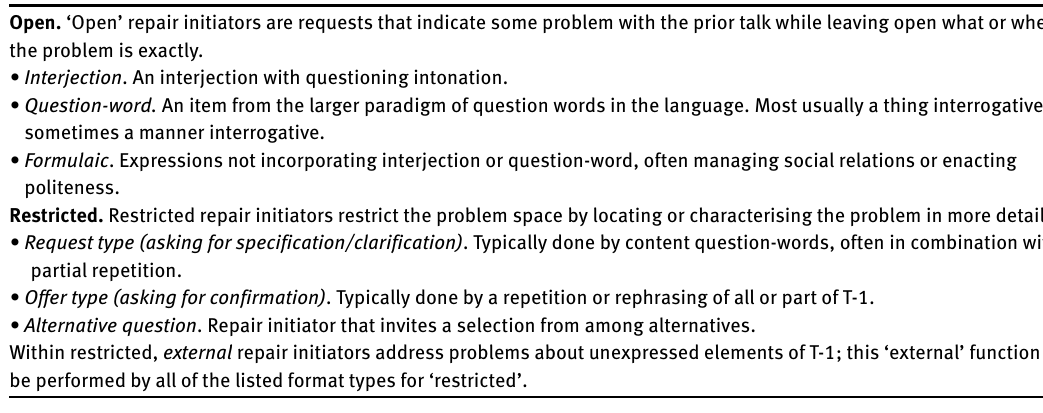
Table 2: Some basic format types for other-initiation of repair Open. ‘Open’ repair initiators are requests that indicate some problem with the prior talk while leaving open what or where the problem is